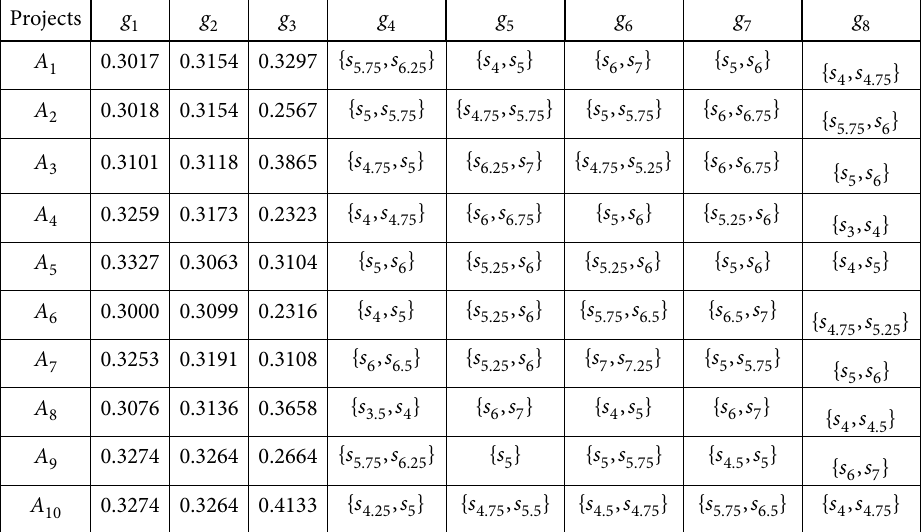
Table 5. Normalized evaluation matrix of projects in terms of the non-financial dimensions Projects g